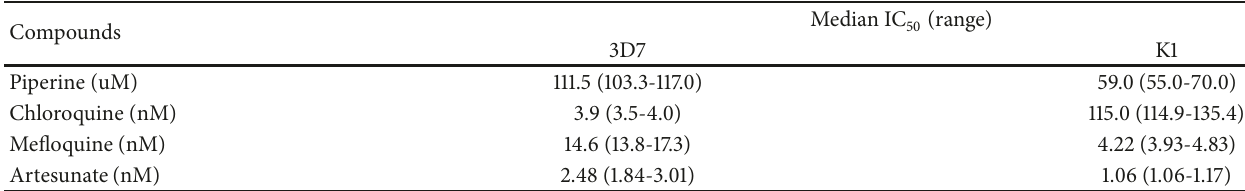
Table 2: Antimalarial activities expressed as IC 50 values of piperine, chloroquine, mefloquine, and artesunate in 3D7 and K1 P. falciparum clones. Data are presented as median (range) value of three independent experiments, triplicate